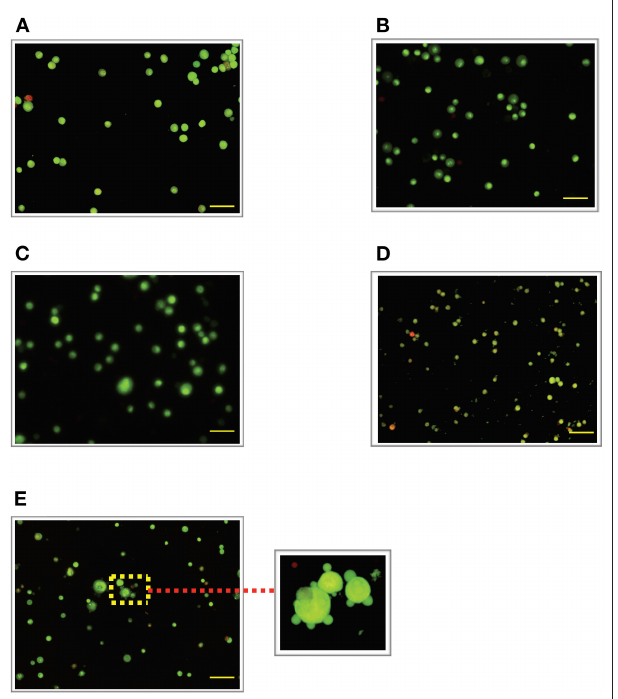
FIGURE 5 | Acridine orange and propidium iodide nucleic acid binding dyes in LPS-stimulated cells. Cells were stimulated with 6 µ g/mL LPS for (A) . Control, (B) . 12, (C) . 24, (D) . 48, and (E) . 72h. Cells were stained with AO/PI to examine their morphological changes, where the green color represents AO, which stains live and dead nucleated cells while the red color represents PI, which stains dead nucleated cells. Representative fluorescence images from inverted fluorescence microscope. Field of views for each time point from three independent experiments. The cells lost membrane integrity with yellow to orange color change, indicating pre-early and early apoptosis. Pictomicrographs were taken with original magnification (10 × ); the scale bar represents 100 µ